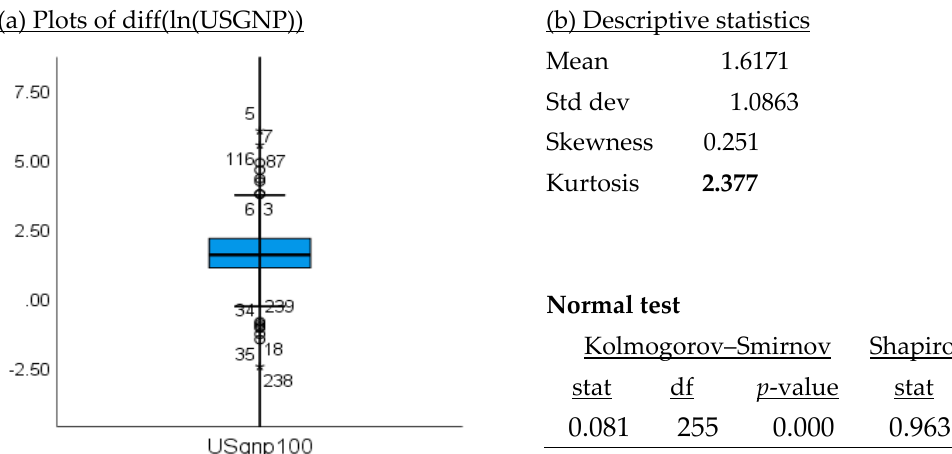
Figure 12. Plots and descriptive statistics of USGNP data.